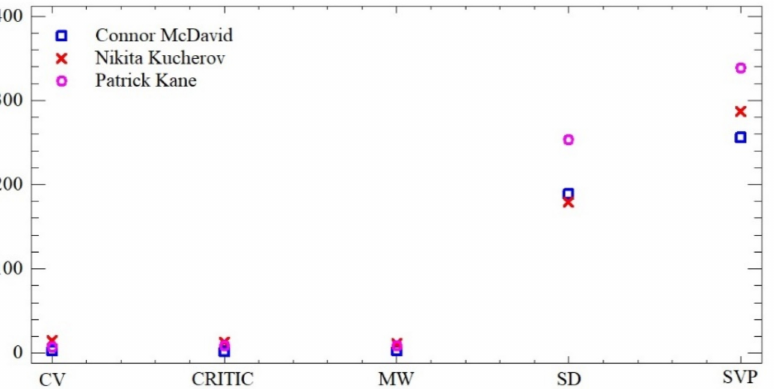
Figure 13. Ranking of selected players within the completed analysis (TOPSIS combined with CV, CRITIC, MW, SD and SVP).